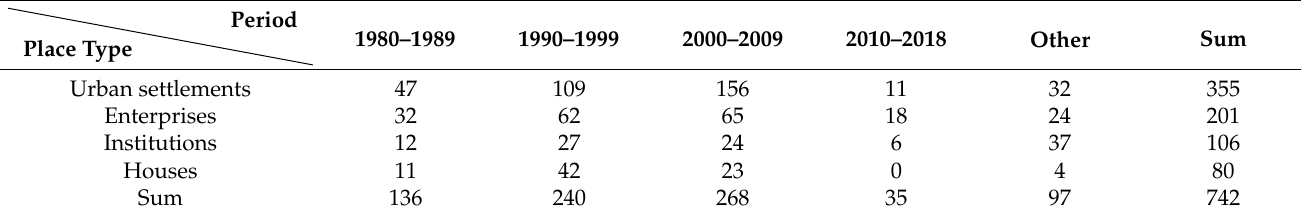
Table 8. Place types in the north of Haikou: the top four types of changes in the total number of place names in Haikou in different periods.